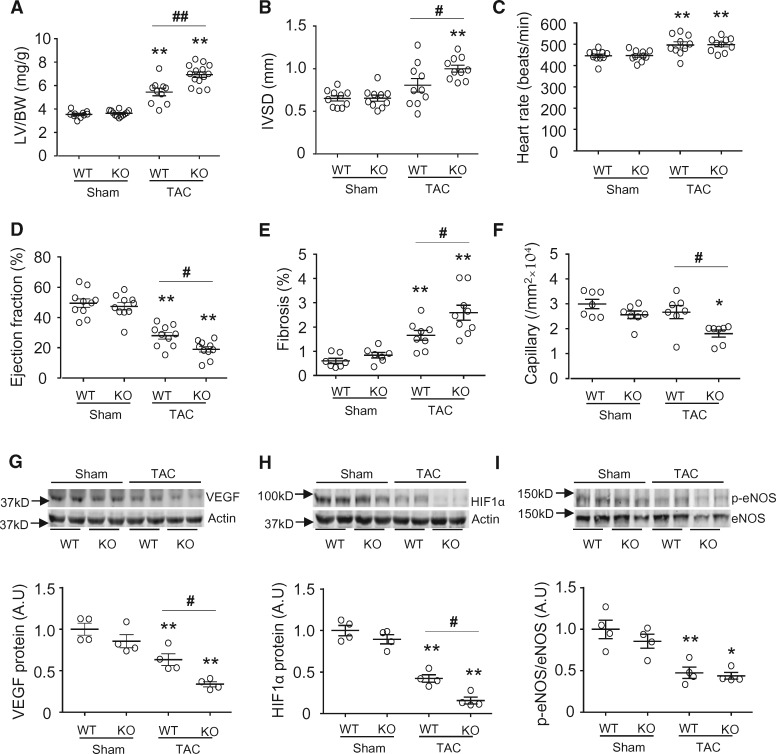
Nox4-null mice have exaggerated cardiac hypertrophy and dysfunction in response to TAC. (A) Left ventricle/body weight (LV/BW) ratio 2 weeks after TAC (n = 10–14/group). (B–D) Echocardiographic analysis of WT and Nox4KO mice subjected to 2 weeks TAC (n = 10/group). IVSD, interventricular septal diameter; EF, ejection fraction. (E–F) Mean data for myocardial interstitial fibrosis and capillary density (n = 7–9/group). (G–I) Protein levels of VEGF-A, HIF1α, p-eNOS, and total eNOS in LV of Nox4-null mice compared to WT. Representative immunoblots are shown at the top and mean data below (n = 4/group). VEGF, vascular endothelial growth factor; HIF1α, hypoxia-induced factor-1α; eNOS, endothelial nitric oxide synthase. *P < 0.05, **P < 0.01 vs. respective sham controls. #P < 0.05, ##P < 0.01 vs. WT/TAC, two-way ANOVA with Tukey’s Multiple Comparison Test. All data are presented as mean ± SEM.